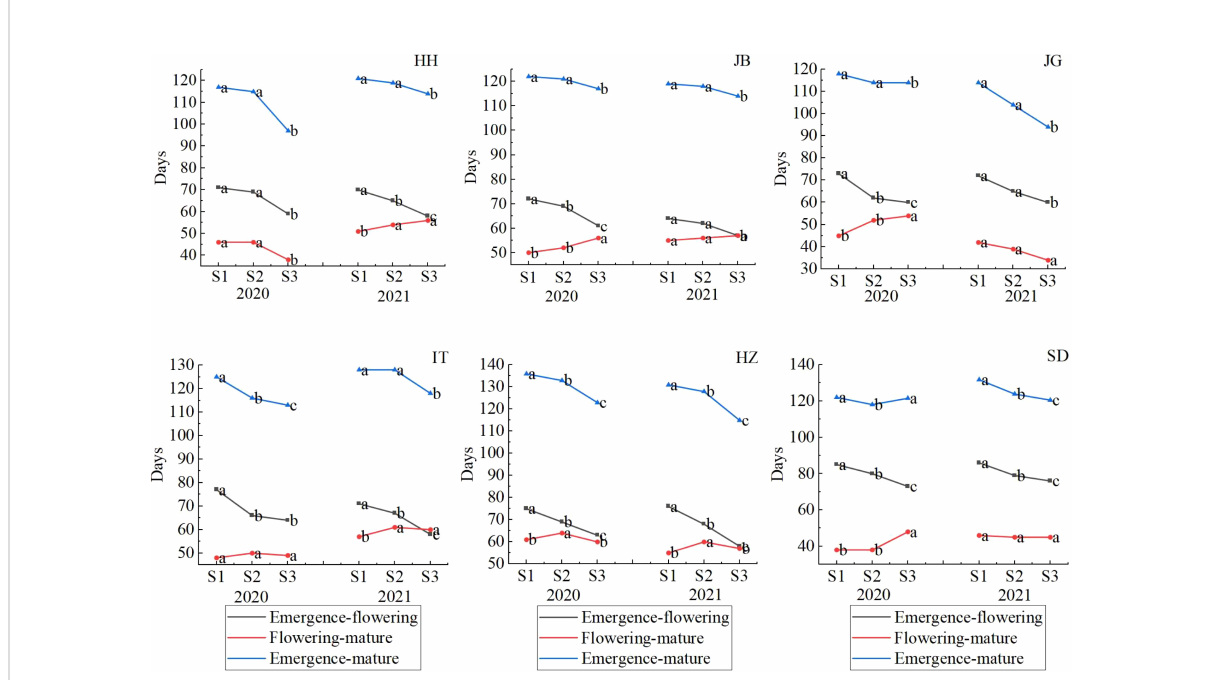
FIGURE 10 Effects of sowing dates on sorghum development progress in different locations in 2020-2021.Letters (a – c) are used to label the difference signi fi cance at 0.05, and the same letter means not signi fi